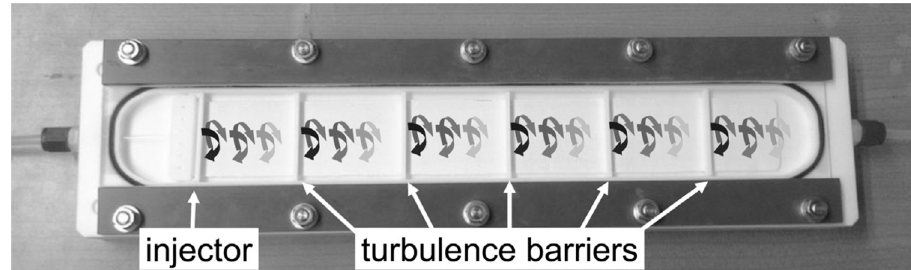
Figure 36. Modified bed flow photoreactor with movable injector and turbulence barriers. Reproduced